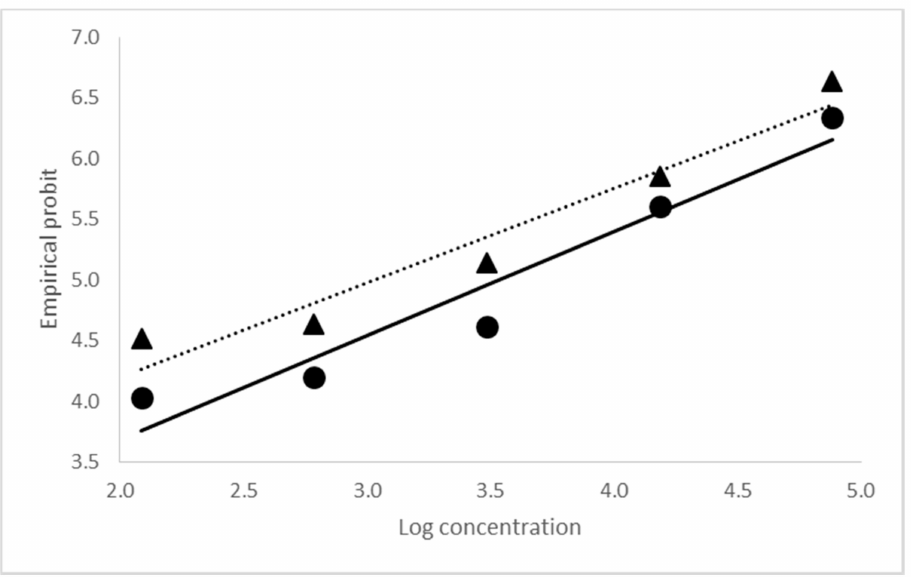
Figure 1. Concentration-response probit lines for CrleGV-SA produced in 2000 (circles and solid line) and 2015 (triangles and dotted line) against neonate T. leucotreta